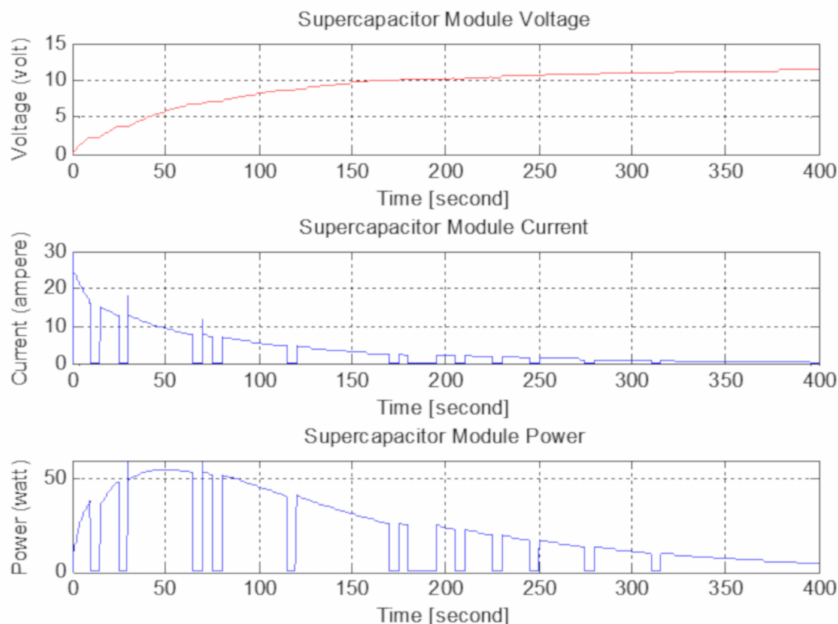
Figure 13. The simulation results of the supercapacitors for the variable solar